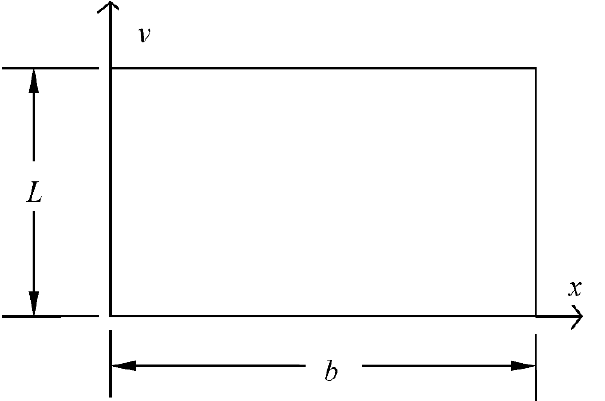
Figure 1. Levy-type solution boundary conditions with coordinate system convention.